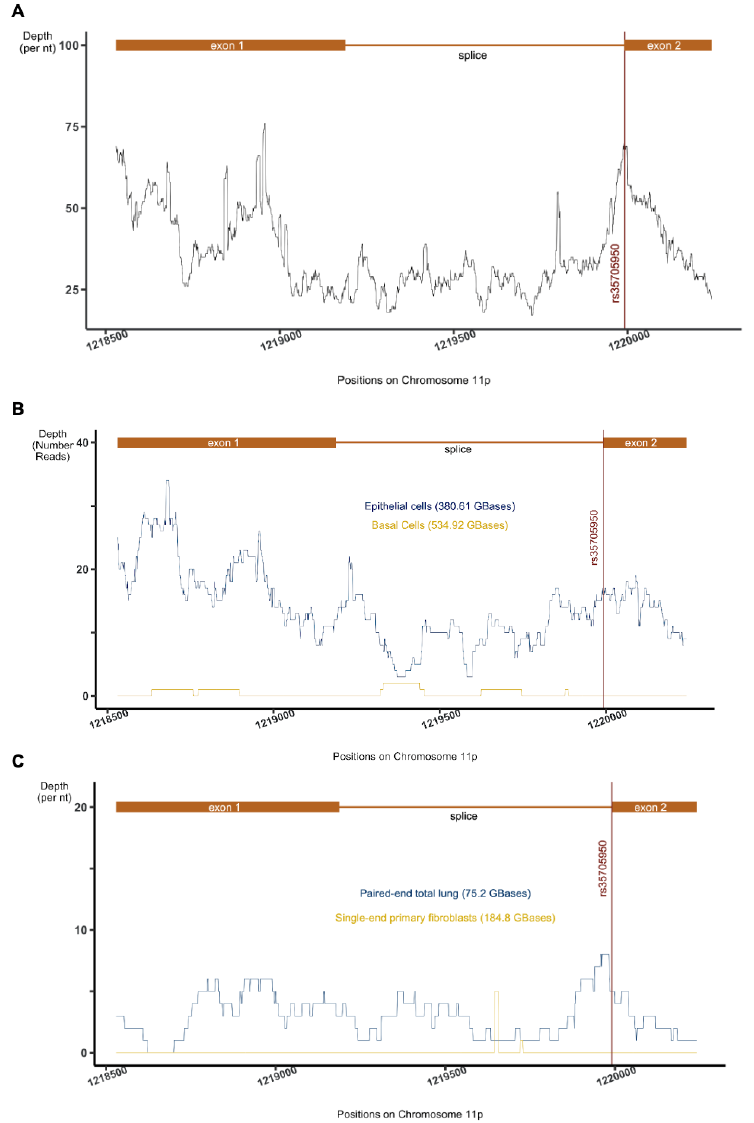
Figure 1. RNA-SEQ data processing results. Depth of coverage spanning chromosome 11: 1,218,530– 1,220,242 collected from ( A ) 27 studies (3.9 TBases), ( B ) a single dataset (SRP082973) comparing epithelial to basal cell expression, and ( C ) 3 IPF-related lung-tissue (SRP033095) and fibroblast (SRP151008 and SRP175341) studies. The position of rs35705950 is indicated by a red vertical line and the AC061979.1, primary transcript and spliced exons are indicated in orange.